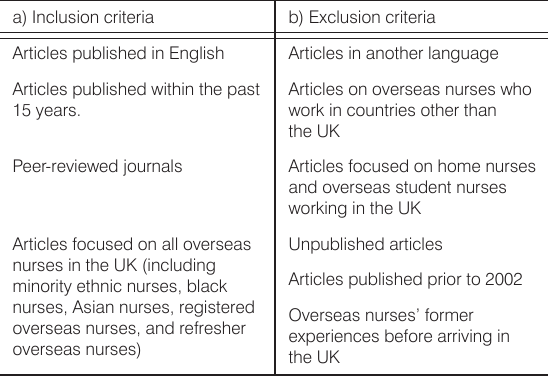
Table 1. Inclusion and exclusion criteria